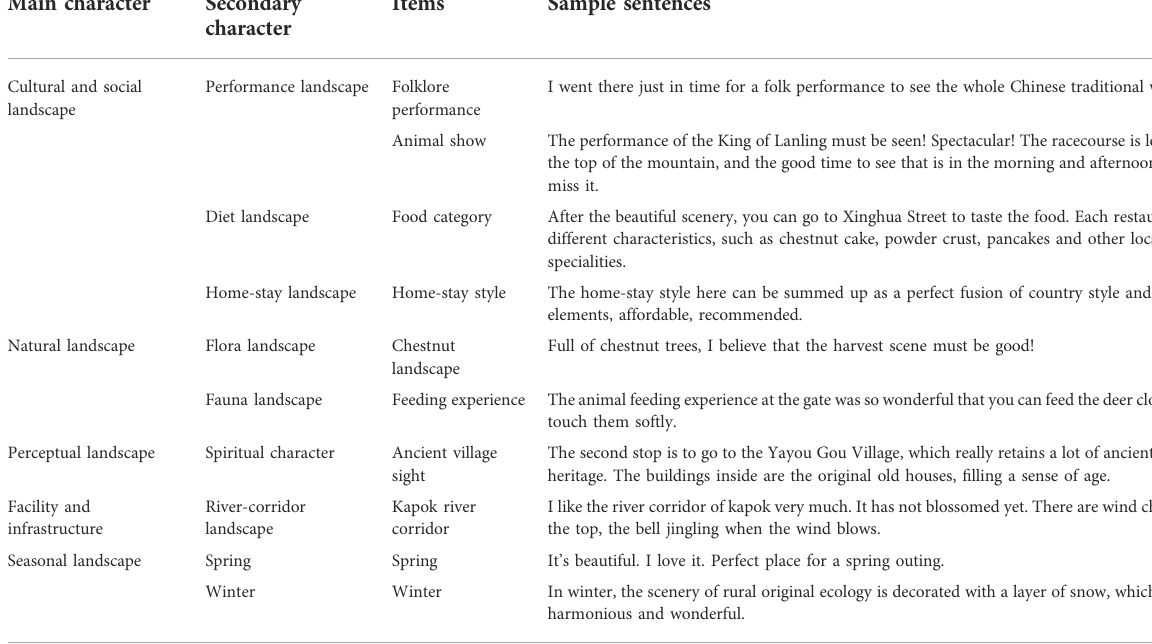
TABLE 2 Examples of landscape character coding of comments in Yayou Gou